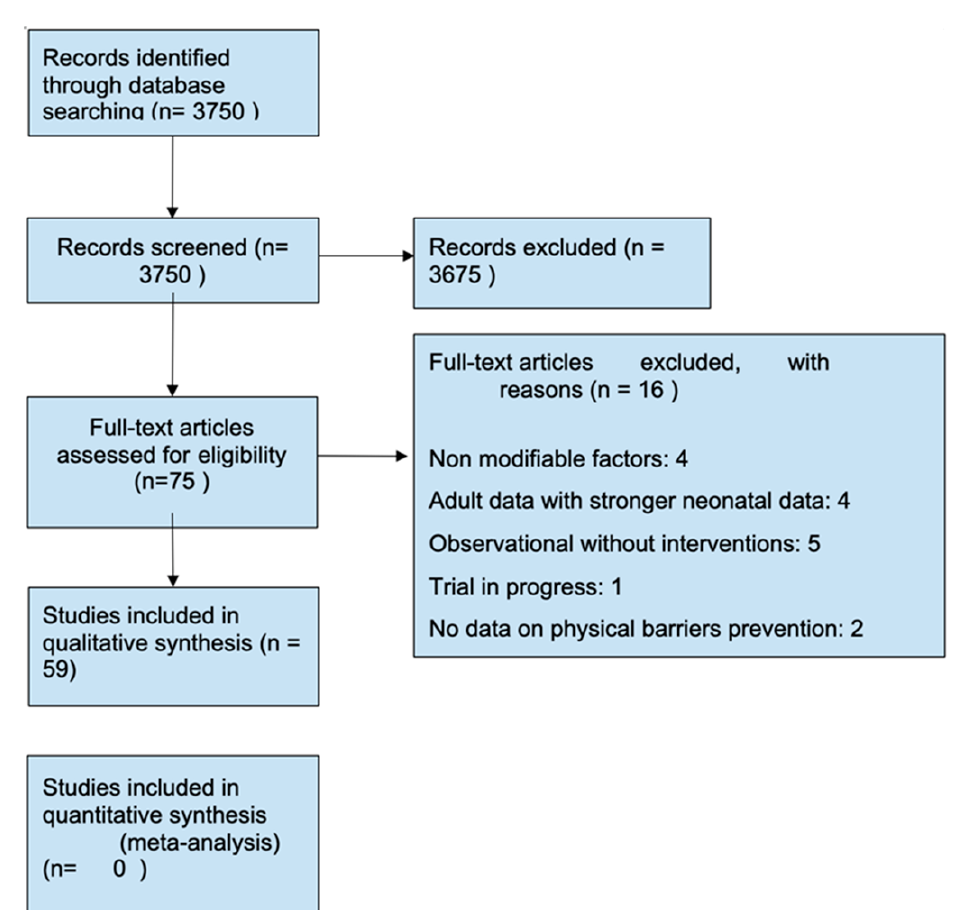
Figure 1. Prisma